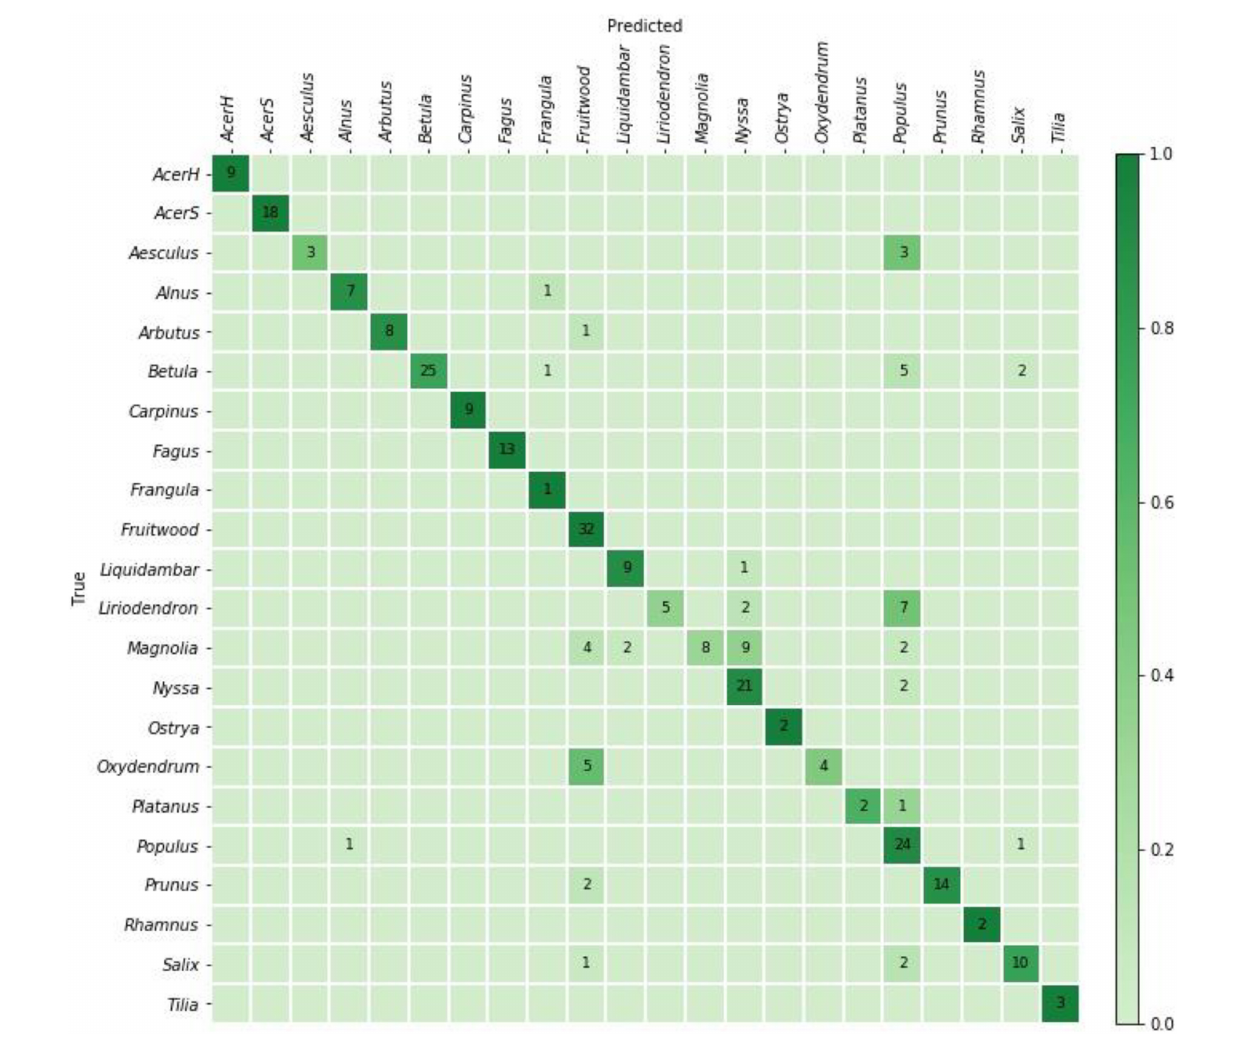
FIGURE 4 | Confusion matrix for the field model predictions on 284 PACw specimens. The top-1 and top-2 specimen-level accuracies were 80.6 and 90.5%,